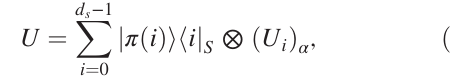
FIG. 3. Strictly incoherent operations on system S constructed by an incoherent unitary interaction with an ancilla α . An operation is split into a controlled unitary followed by a measurement on the ancilla in a basis j ϕ μ i and an incoherent unitary V μ on the system conditioned on the meas- urement outcome μ